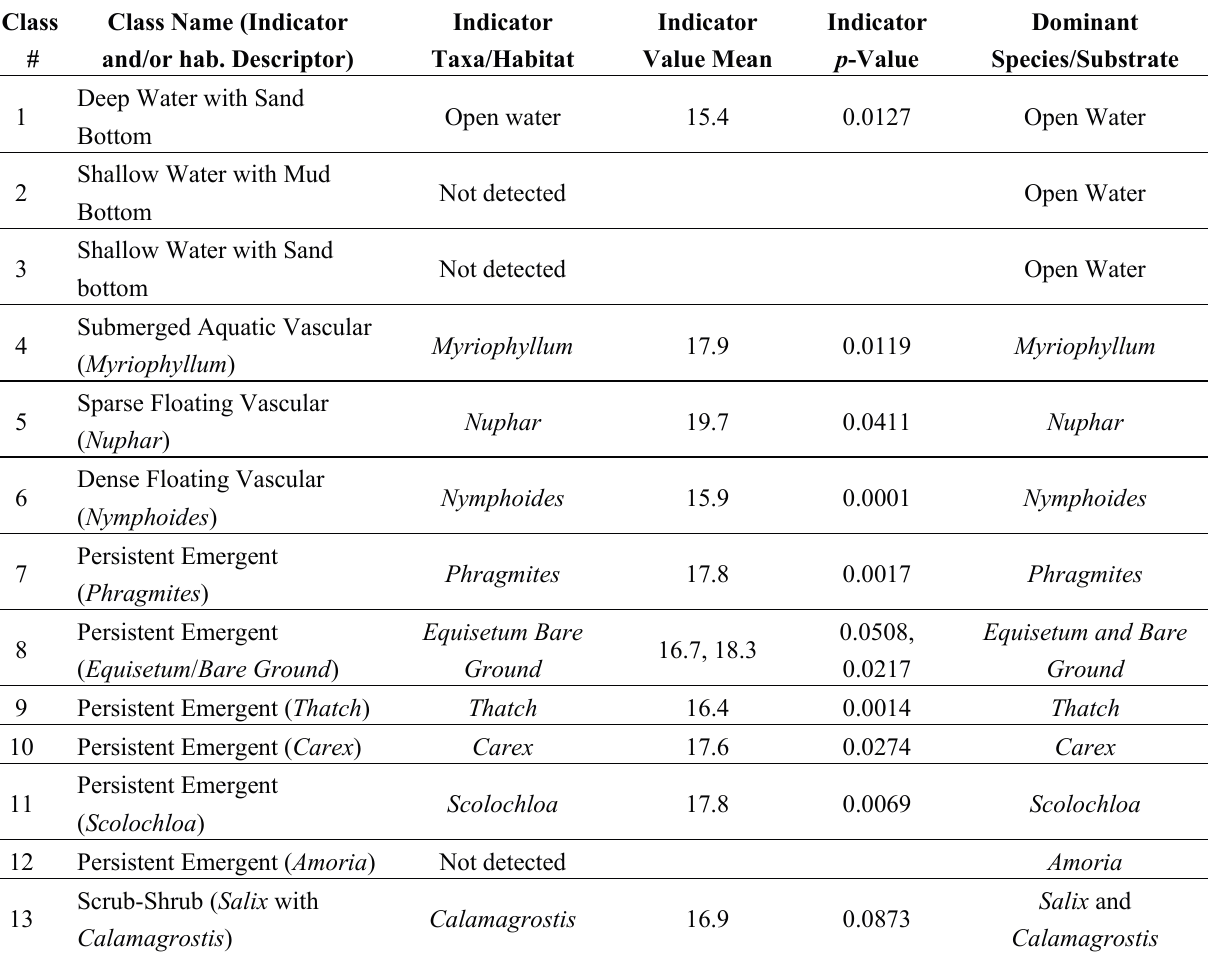
Table 3. Indicator and dominant species of 13 classes of aquatic and wetland habitats for Level 4 of the